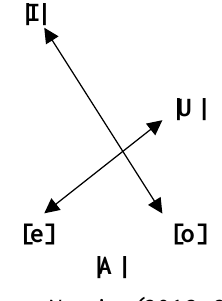
Figure 2 . Distance between the elements |I| and |U| and mid-vowels [o] and [e] respectively